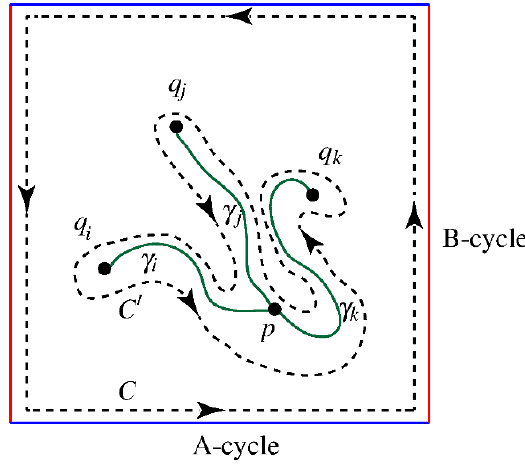
Figure 3 . The path (cid:13) i connects p and q i . Since this is a two-torus, the blue (red) edges are identi(cid:12)ed, and are the A-cycle and the B-cycle, respectively. The contour C = ABA (cid:0) 1 B (cid:0) 1 can be deformed into the contour C 0 , which can be decomposed into small cycles surrounding (cid:13) i ’s. is because by the Cauchy theorem, the sum of residues of dF=F must be zero and it has the residue +1 at a simple zero of F and (cid:0) 1 at a simple pole, with obvious generalization when zero or pole have multiplicity. If q pole at p = f z = 0 g is reduced by the number of q that the function F has double (or more generally multiple) zero at that